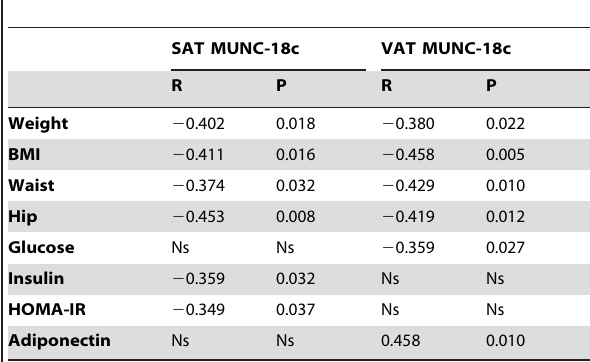
Table 2. Bivariate correlations between Munc18c gene expression from subcutaneous (SAT) and visceral (VAT) adipose tissue gene expression and anthropometric and metabolic characteristics in the whole population.